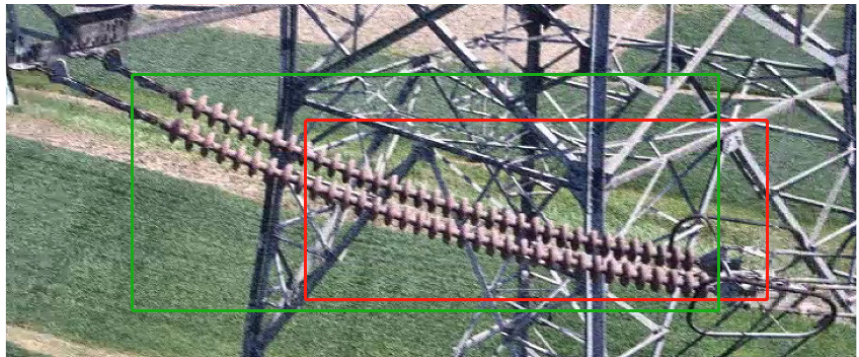
Figure 3. Insulator true label frame and prediction